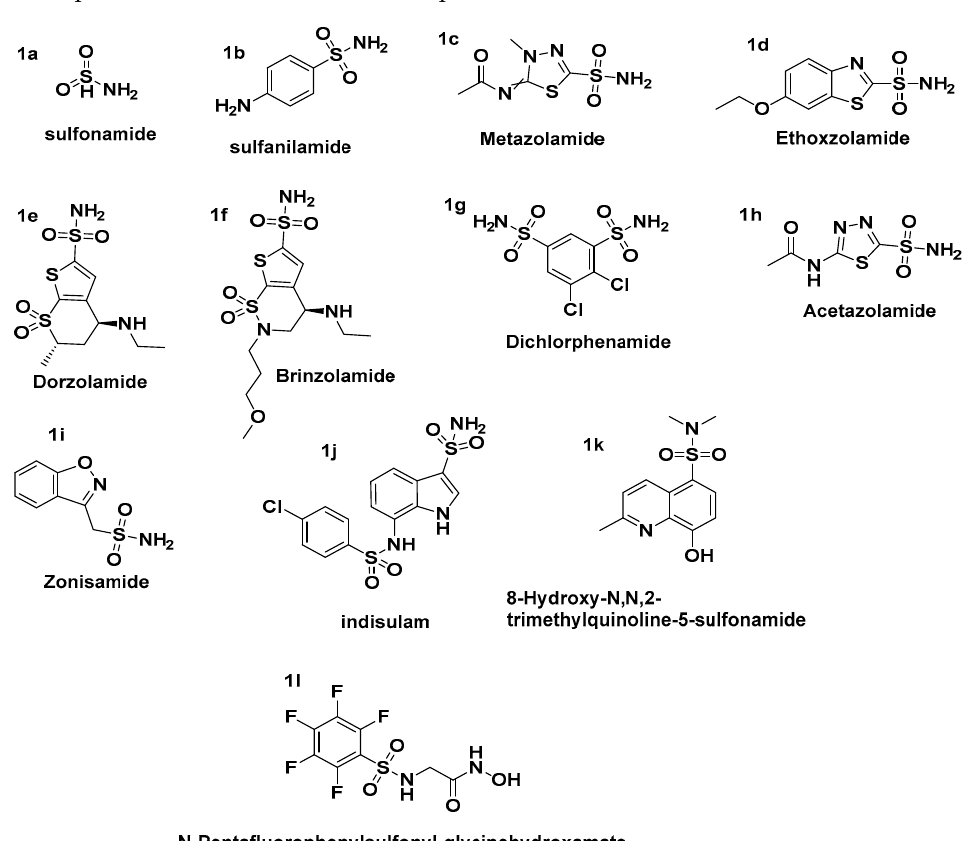
Figure 1. Some of the known sulfonamide derivatives as potent carbonic anhydrase inhibitors.